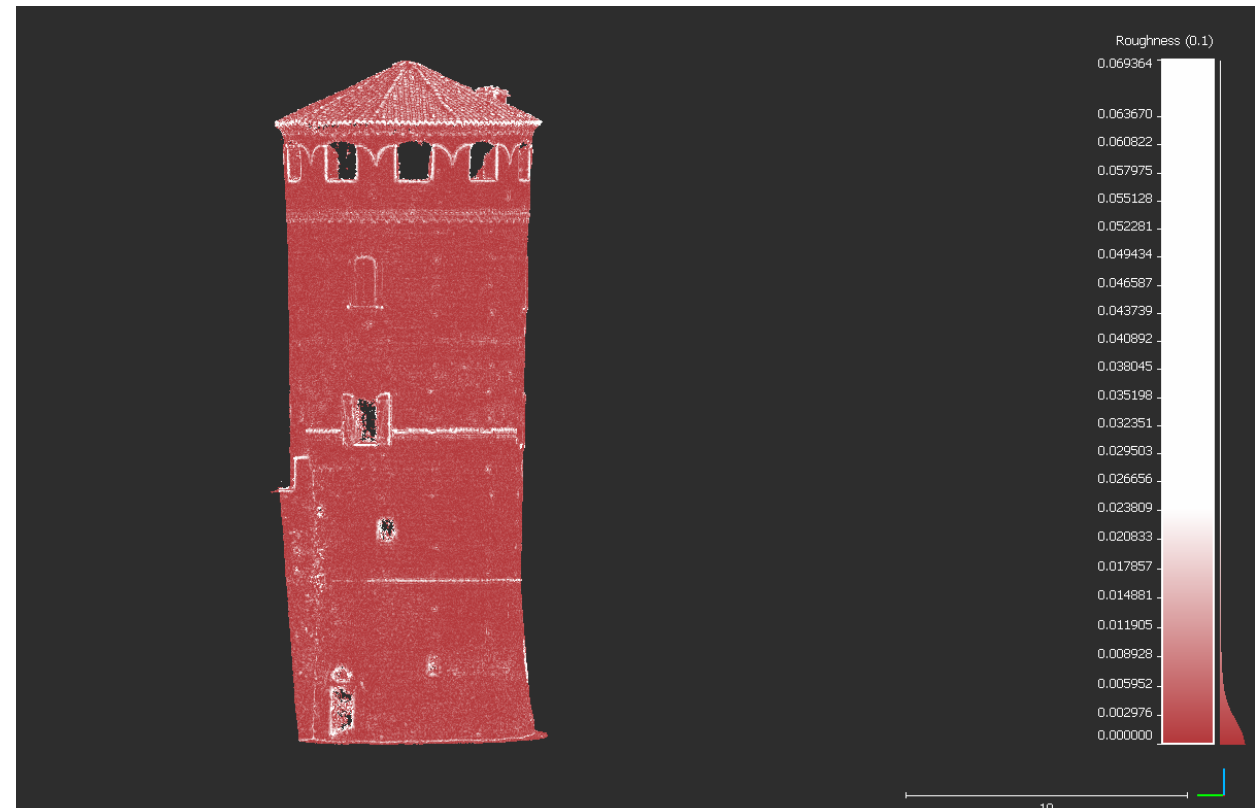
Figure 28. Roughness analysis of the photogrammetric data: RMSe 0.006 m; standard deviation 0.005 m. White points are related to roughness and noise